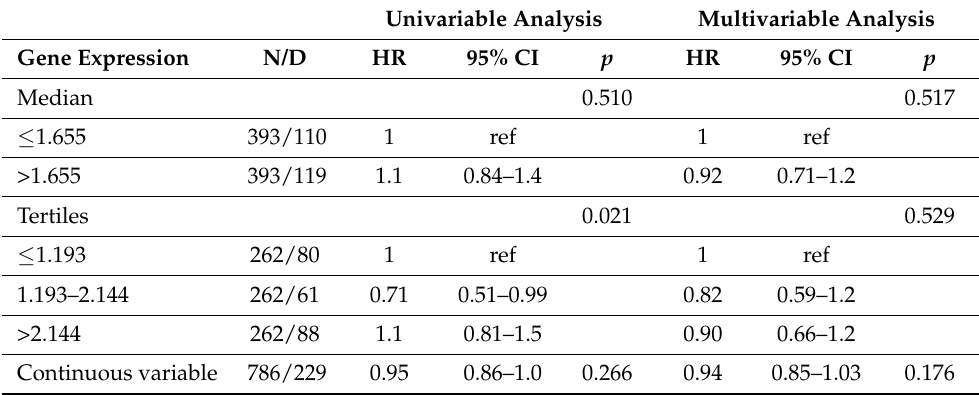
Table 12. Overall Survival of 786 NB patients in relation to RSAD2 expression levels evaluated by the Cox